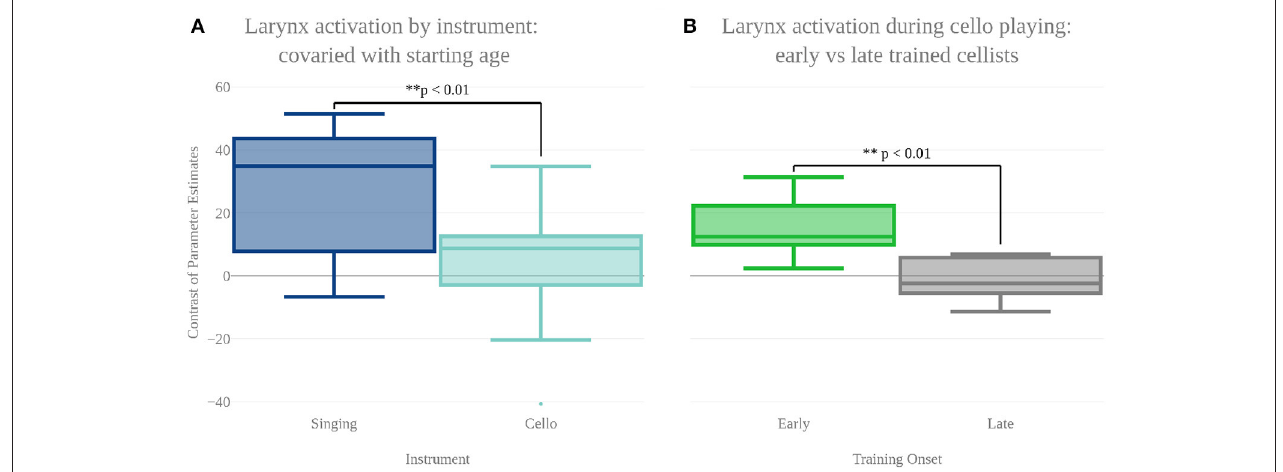
FIGURE 7 | (A) Contrast of parameter estimates (units arbitrary) in larynx area of motor cortex for singing (blue) and cello playing (turquoise). When starting age is included as a covariate, anova shows a significantly more activity in larynx area during singing than cello playing. (B) Mean contrast of parameter estimate values in